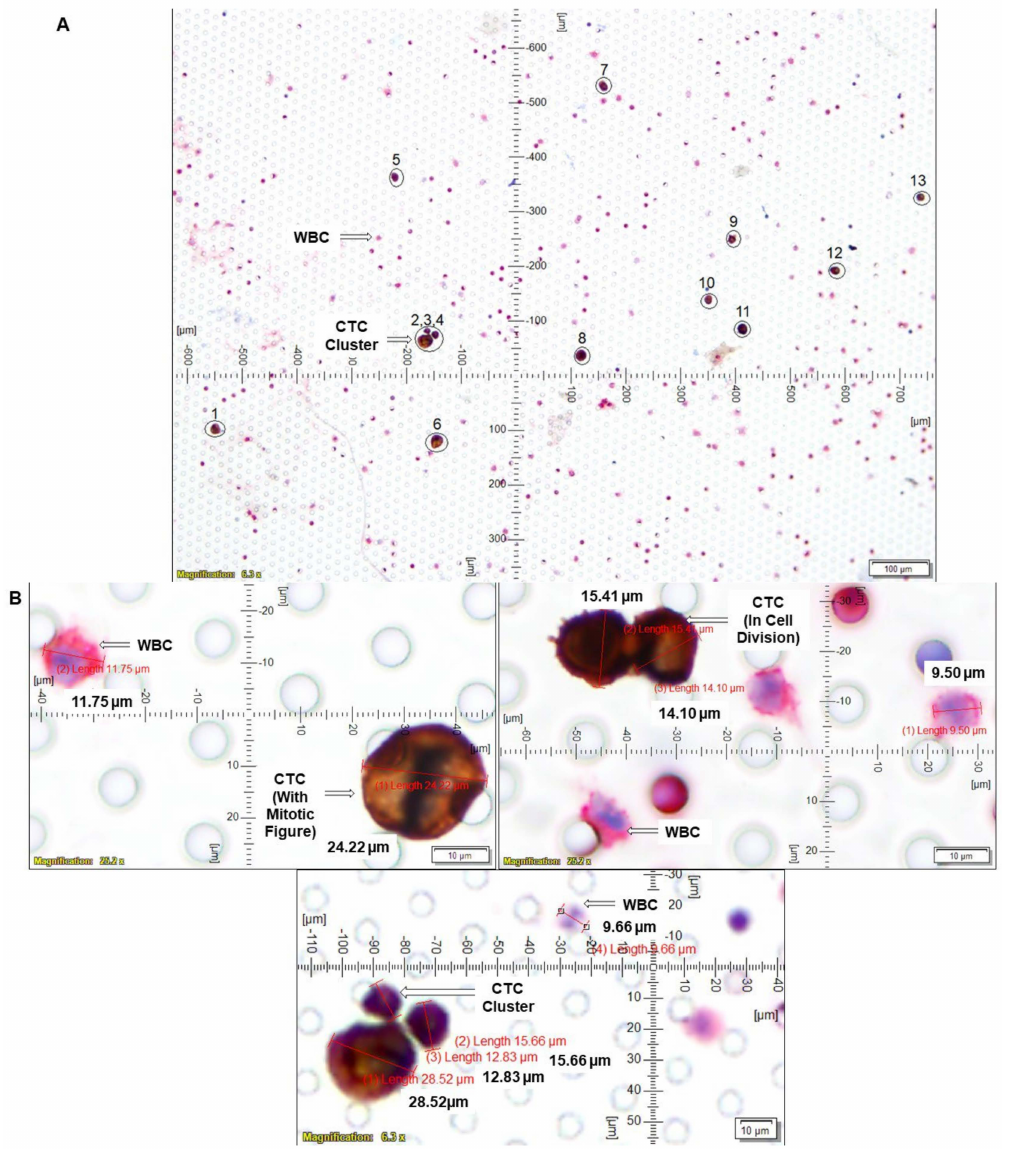
Figure 5. Clinical relevance of determination of the number of CTCs using a single case study: we determined CTC by ICC × 2 from the blood of a patient with grade 2 stage I endometrial cancer: CTCs were captured from blood samples from the patient and enumerated using ICC × 2 ( A , B ). Blood samples were spiked (Spiked samples) with titrating number (250 cells/100 cells) of NCI-H441 cells separately for ICC × 2. For ICC × 2, pictures were taken at 40 × objective of an Olympus BX43 Microscope. The magnification, scale bar, and digital reticle are represented for each photomicrograph. We recorded up to 100 CTCs in the 7.5 mL of the blood with 13 CTCs in a single microscopic field ( A ) and mitotic CTCs with a mitotic figure and a cluster of 3 CTCs ( B ). The immunocytochemistry- photomicrographs presented with a scale bar, magnification information, digital reticule, as well as the diameters ( µ m) of CTC and a representative